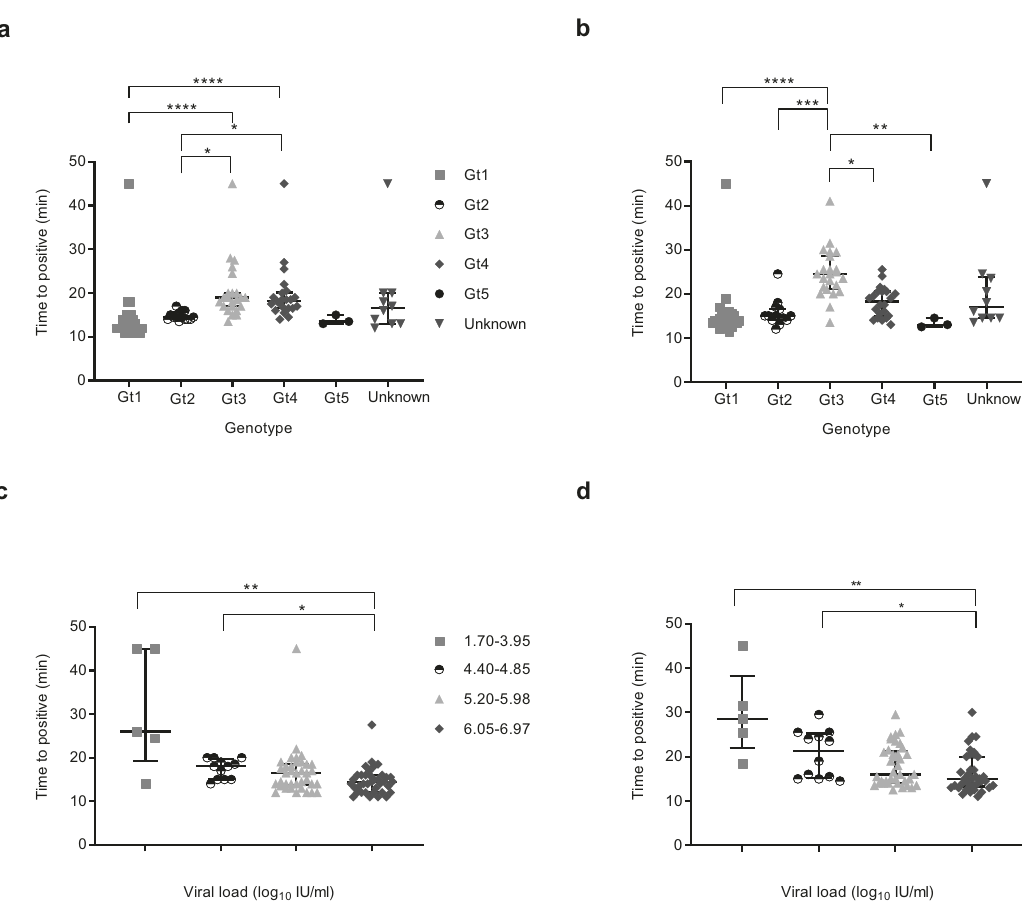
Fig. 1 The effect of genotype and viral load on detection. The central lines indicate median with interquartile range as error bars, and each point on the graph represents the mean of a sample run in duplicate. False negative samples were recorded as time to positive reaction at 45 min. Statistical analysis was performed using a one-sided non-parametric Kruskal-Wallis with Dunn ’ s multiple comparisons test (one-sided). * p ≤ 0.05, ** p ≤ 0.01, *** p ≤ 0.001, **** p ≤ 0.0001. a HCV RNA samples detection based on genotype (Gt): Gt1 (grey square, n = 26), Gt2 (white and black disc, n = 14), Gt3 (grey triangle, n = 23), Gt4 (grey lozenge, n = 22), Gt5 (black disc, n = 3), Unknown (grey inverse triangle, n = 10). Gt1 vs Gt3, p < 0.0001, Gt1 vs Gt4, p < 0.0001, Gt1 vs Unknown, p = 0.1524, Gt2 vs Gt3, p = 0.0101, Gt2 vs Gt4, p = 0.0284, Gt3 vs Gt5, p = 0.1846, Gt4 vs Gt5, p = 0.2814. All remaining groups had p